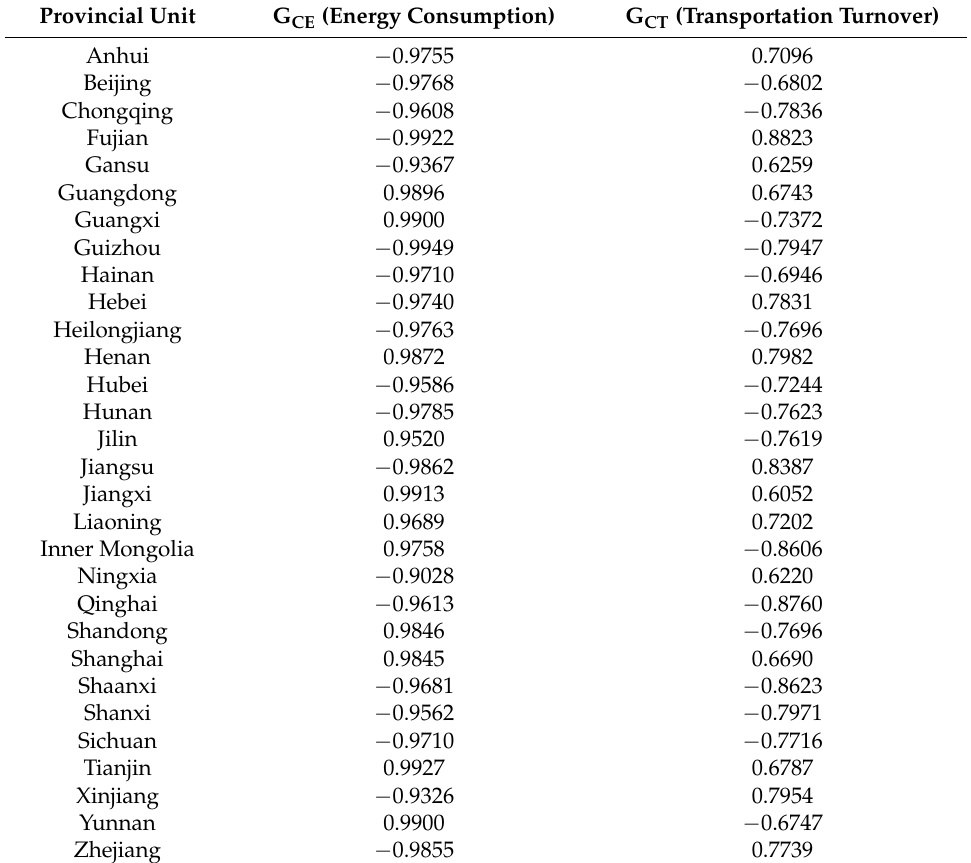
Table 1. GRGs between Two Transport-Related Factors and CO 2 emissions for 30 Provinces and Municipalities of China (1994 to